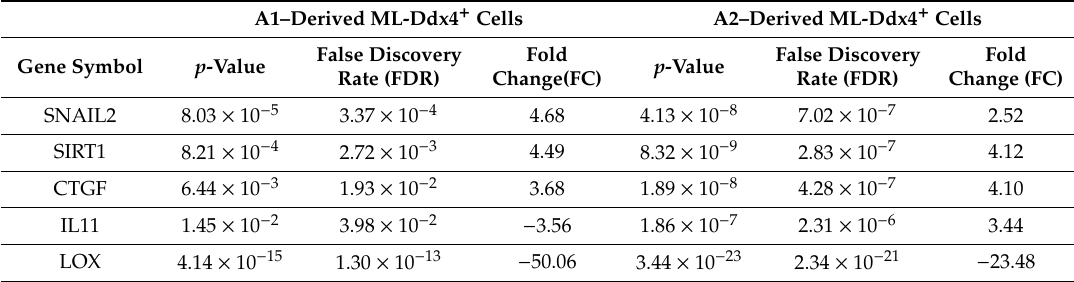
Table 2. DEGs shared in A2780 cells after 48 h co-culture with ML-Ddx4 + cells from both patient groups.